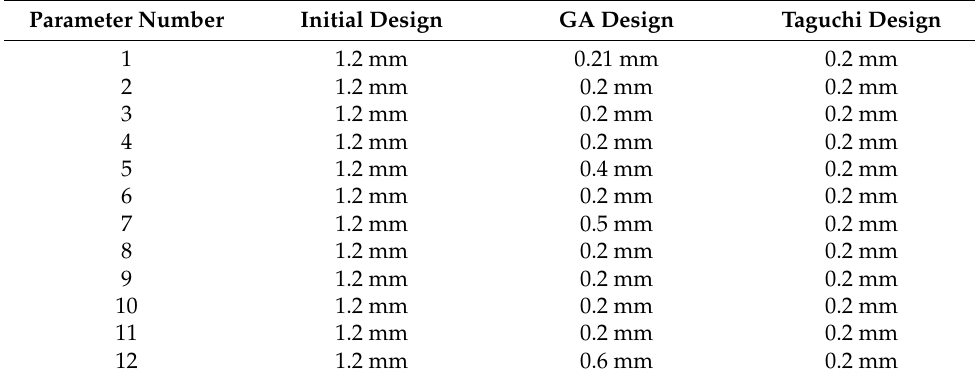
Figure 10. Comparison of three designs in terms of magnetic torque versus angle of deviation.